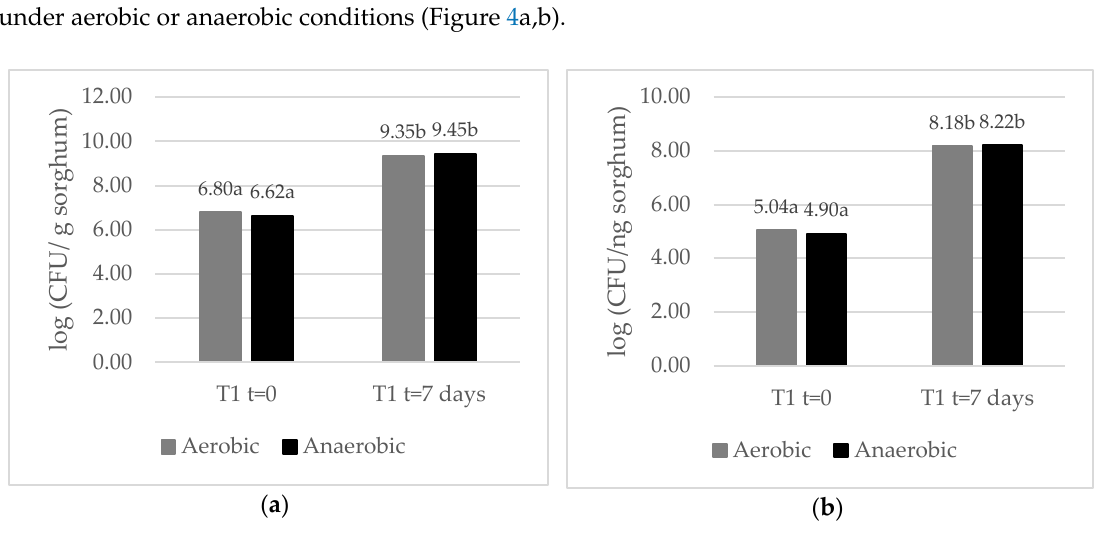
Figure 4. ( a ) Bacterial plate count per sorghum weight in aerobic and anaerobic condition. ( b ) Yeast plate count per sorghum weight in aerobic and anaerobic conditions. Values labeled with different letters are significantly different, as calculated by a LSD Fisher Test α = 0.05.